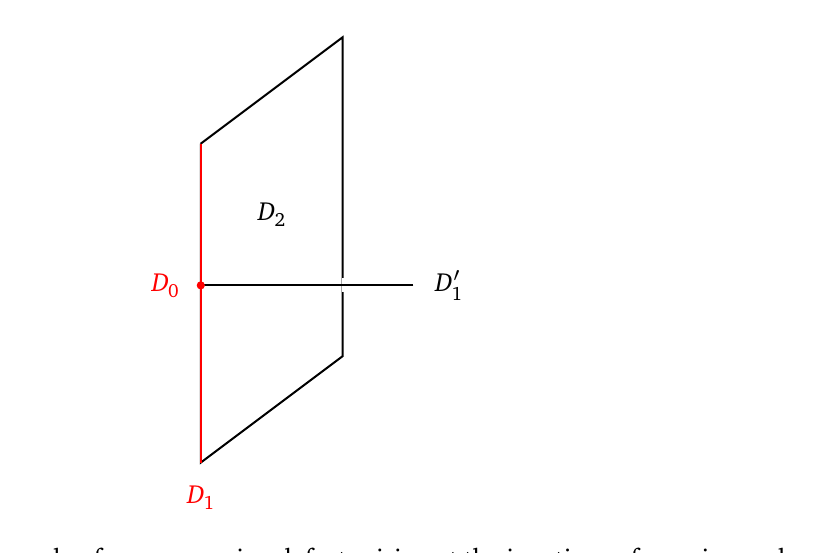
itself is a non- 1 2